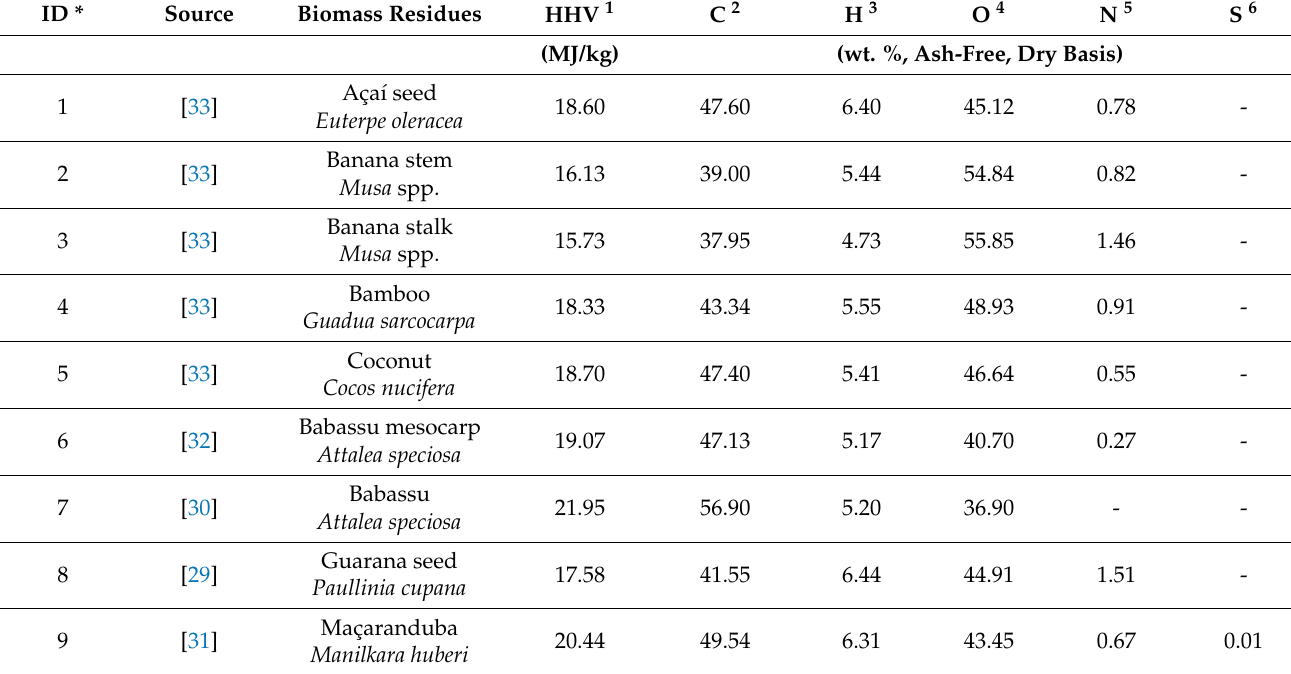
Table 2. Thermochemical data on Amazonian biomasses used for ultimate HHV equation